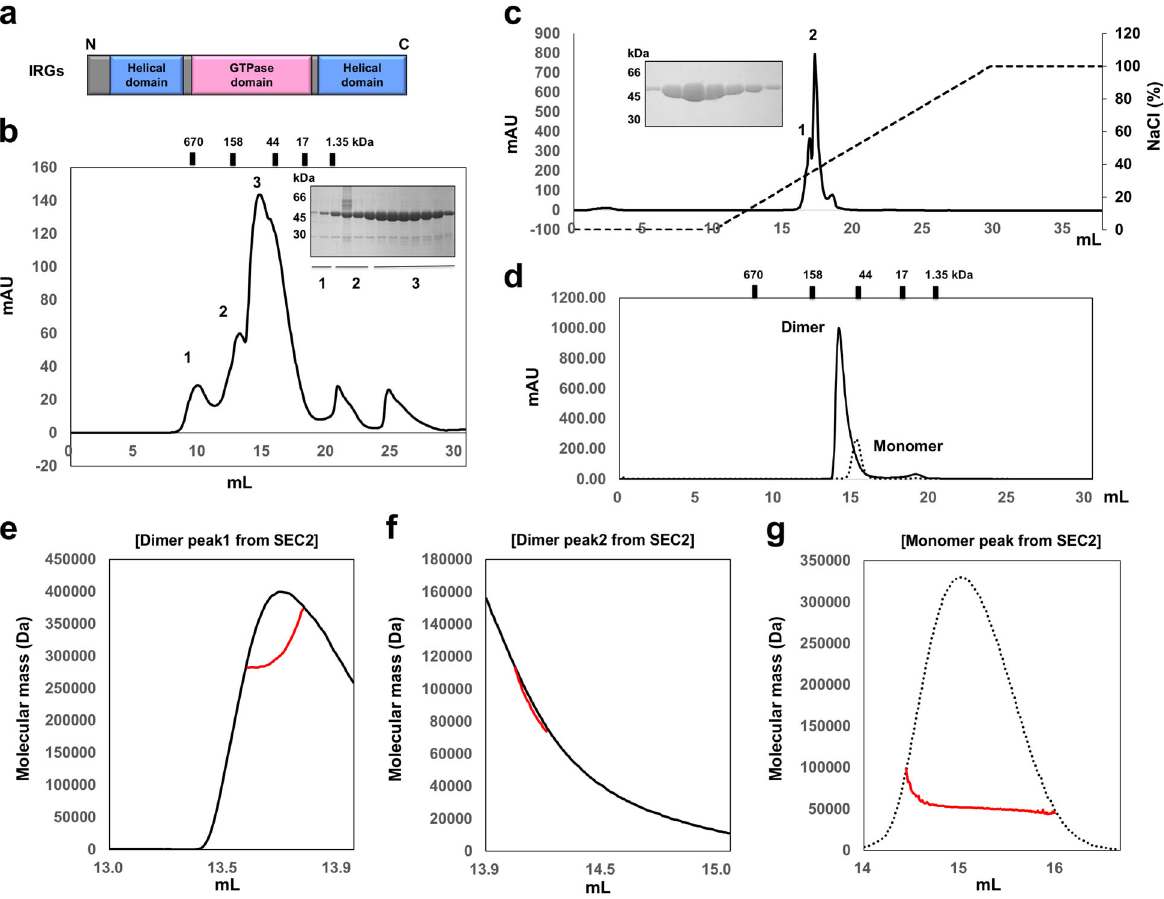
Fig. 1 Puri fi cation and characterization of IRGB10. a Domain boundary of the immunity-related GTPase (IRG) family; N and C indicate the N-terminus and the C-terminus, respectively. b Pro fi le of the fi rst size-exclusion chromatography (SEC). Three peaks were labeled in order. SDS – PAGE for the assessment of identity and purity was provided at the right side of the main peak. Loaded fractions are indicated by black bars with numbers. c Pro fi le of the ion-exchange chromatography. Two peaks, 1 and 2, were labeled in order. Black dotted line indicates the gradient of NaCl. d Pro fi le of the second SEC. e – g Multi-angle light scattering (MALS) pro fi les derived from the second peak of the fi rst SEC ( e ), the third peak of the fi rst SEC ( f ), and the monomer peak of the second SEC ( g ). Red line indicates the experimental molecular